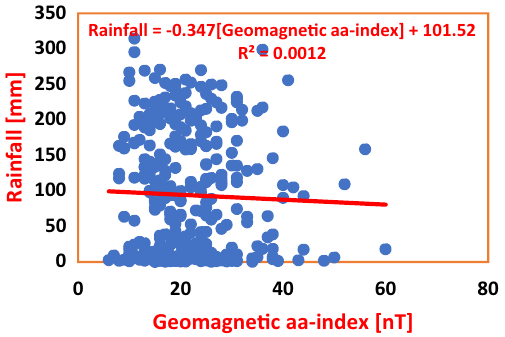
Figure 8. Regression of Geomagnetic aa-index on Rainfall in PHC during Solar Cycles 22–24. The percentage impact of Geomagnetic aa-index on Rainfall is observed to be 0.12%, which could only cause a ‘too small effect’. I surffices to state that the model shows that Rainfall variability in this study area is not forced by Geomagnetic aa-index.